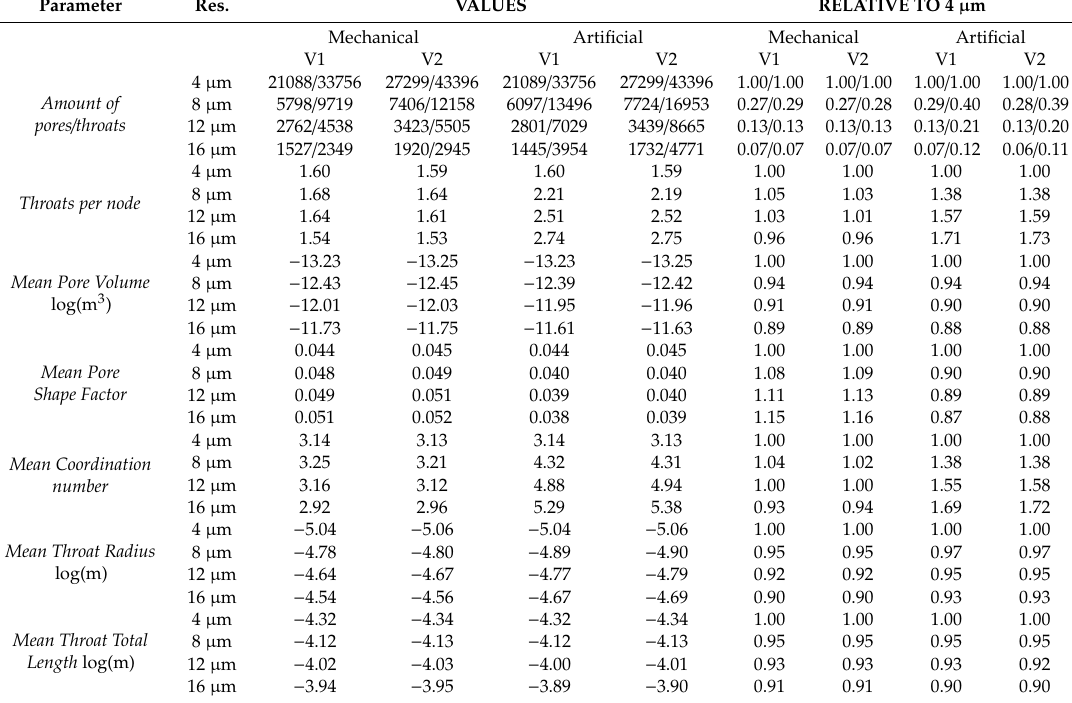
Table 2. Influence of resolution on mean pore network properties, studied for two volumes and for mechanical and artificial resolution reduction. Relative di ff erence with expected highest resolution data is added to check the decay of